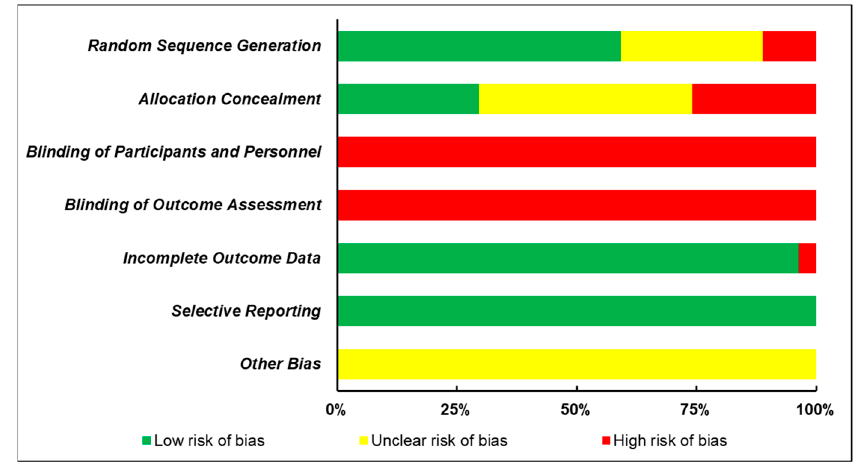
Figure 2. Risk of bias evaluation of included studies.